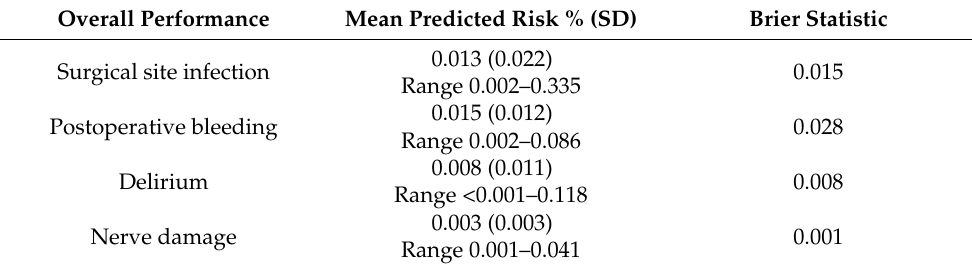
Table 3. Mean predicted risk, and Brier statistic per